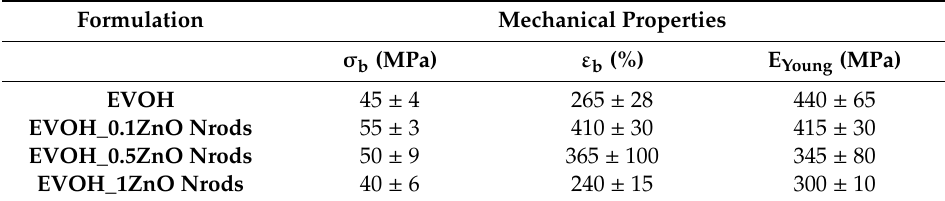
Table 3. Mechanical properties of EVOH-based systems.